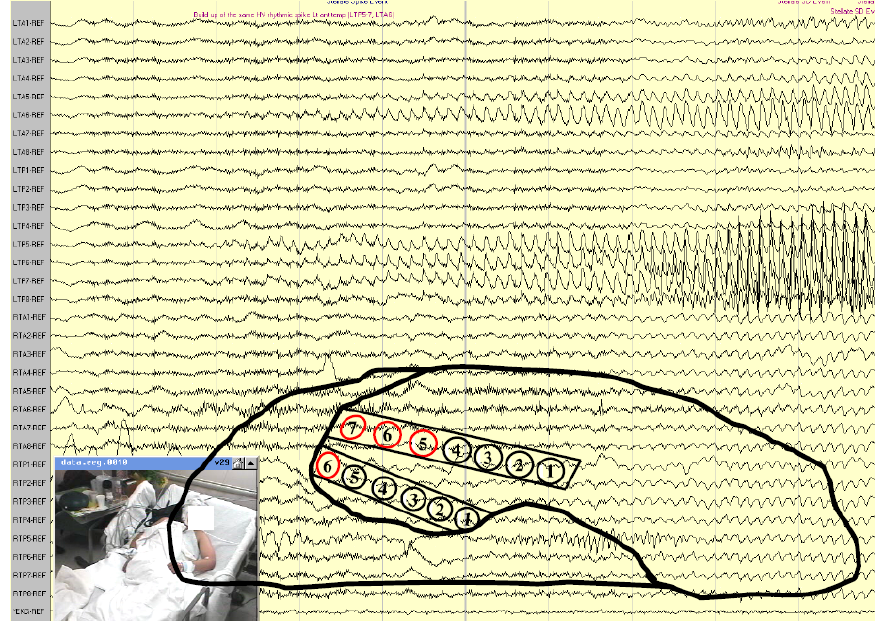
Figure 5. Ictal onset EEG recording through two 1 × 8 subdural strips placed over the basal temporal region in a patient with left temporal lobe epilepsy (TLE). Buildup of rhythmic sharp discharges initiated at a few electrodes (red circles) before rapid propagation to other electrodes and